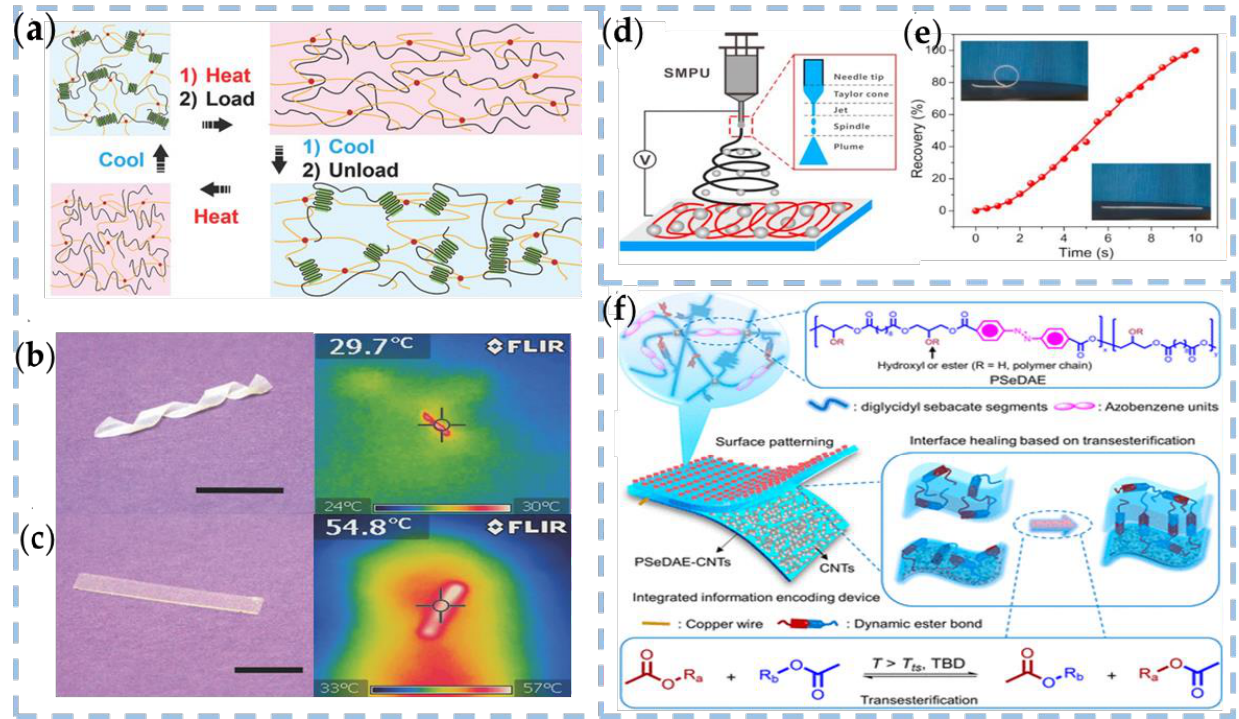
Figure 9. ( a ) Schematics showing the mechanism of shape-memory behavior. ( b ) Sample with temporary spring shape and ( c ) after reverting to the original condition along with the corresponding thermal images [84]. Copyright 2018, WILEY-VCH VERLAG GMBH. ( d ) Schematic illustration of the electrospinning process of SMPU microarchitectures. ( e ) The recovery ratio of a representative MFs mat as a function of the heating time at 75 °C. Insets are photographs of a mat ribbon in the initial circular shape and the completely recovered form [85]. Copyright 2019, ELSEVIER. ( f ) Schematic illustrations of the PSeDAE and resultant IED with an integrated structure [86]. Copyright 2022, AMER CHEMICAL SOC.